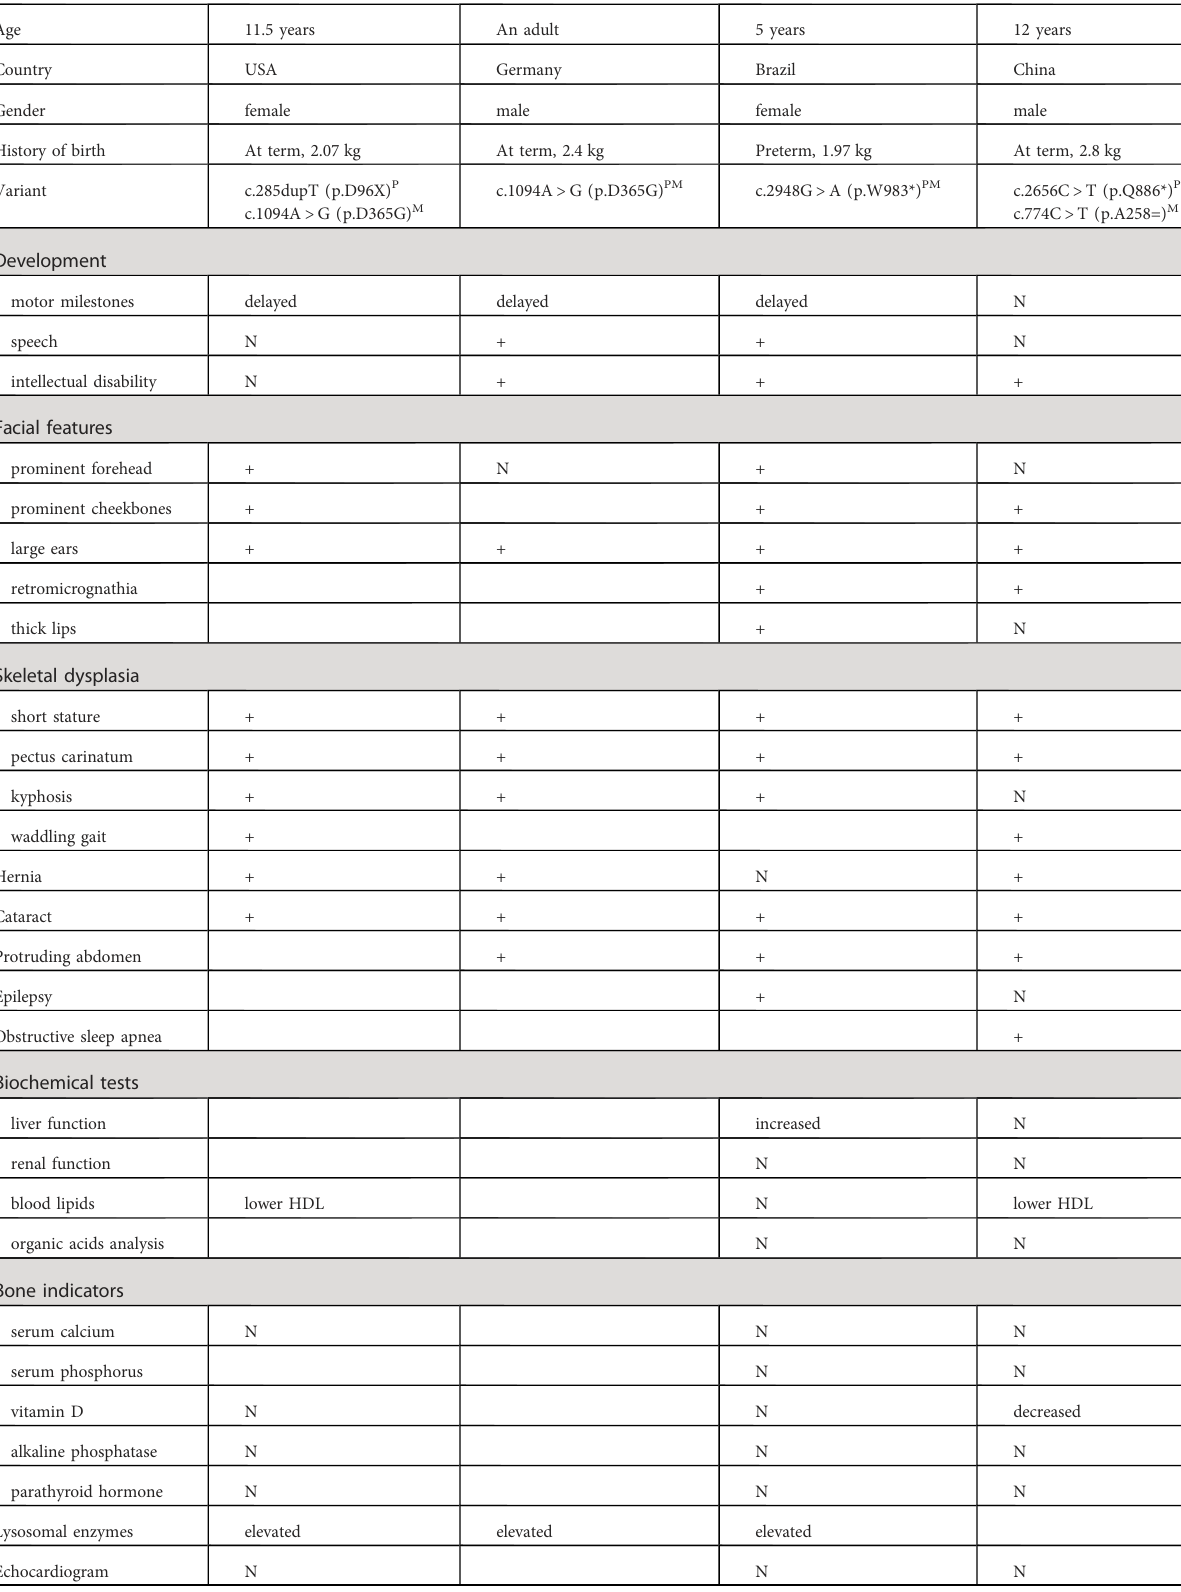
TABLE 1 Summary of the clinical and genetic features of spondyloepiphyseal dysplasia with MBTPS1 mutation reported in the literature vs. our proband. Age